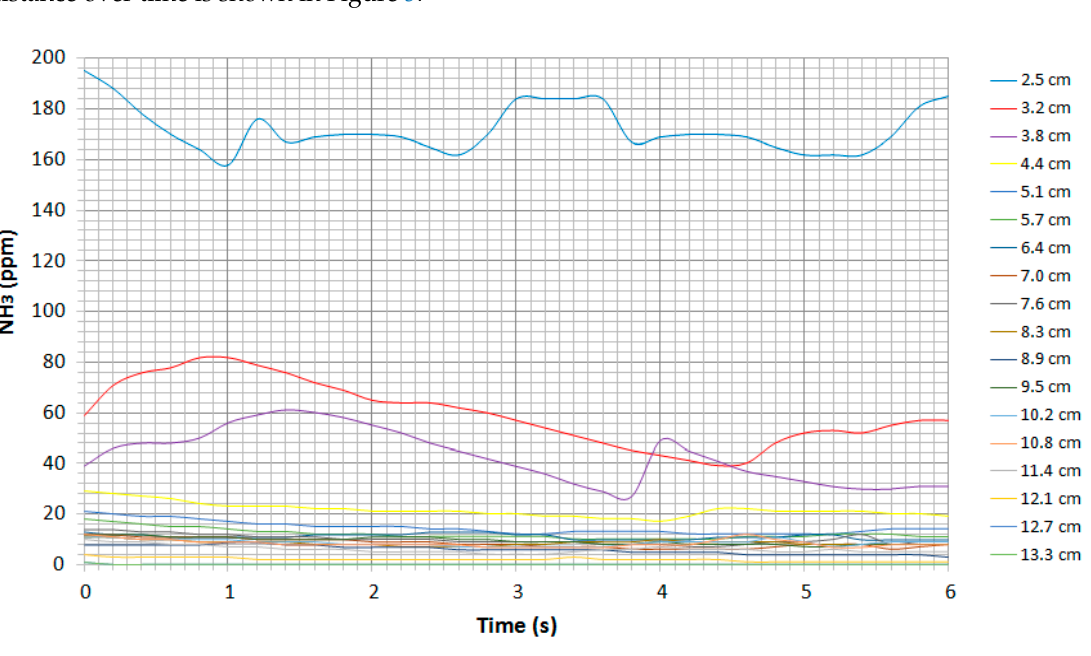
Table 5. Operational sample rate and standard deviation for each sensor.